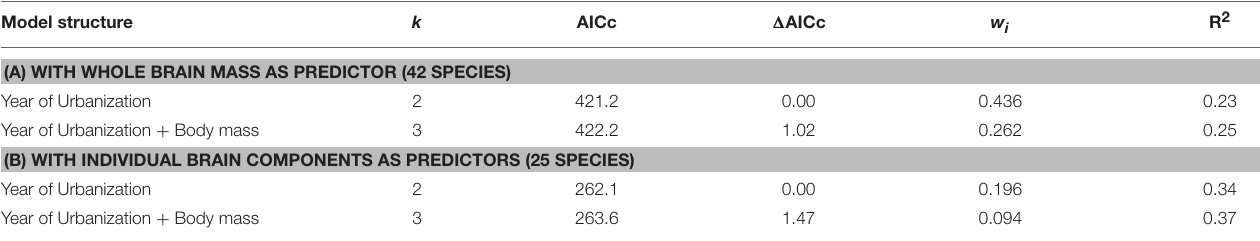
TABLE 1 | The best-ranked PGLS regression models (models with 1 AICc < 2) predicting degree of tolerance across bird species. Model